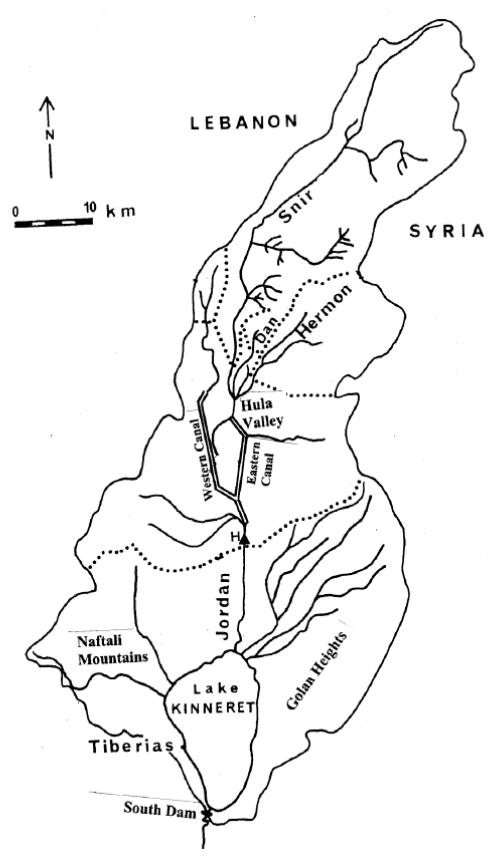
Figure 1. Kinneret Drainage Basin Major Headwaters are Charted: Hermon(Banyas), Snir(Hatzbani), Dan, and “others” H = Huri Bridge; ...... Regional Drainage Sub-units domain.